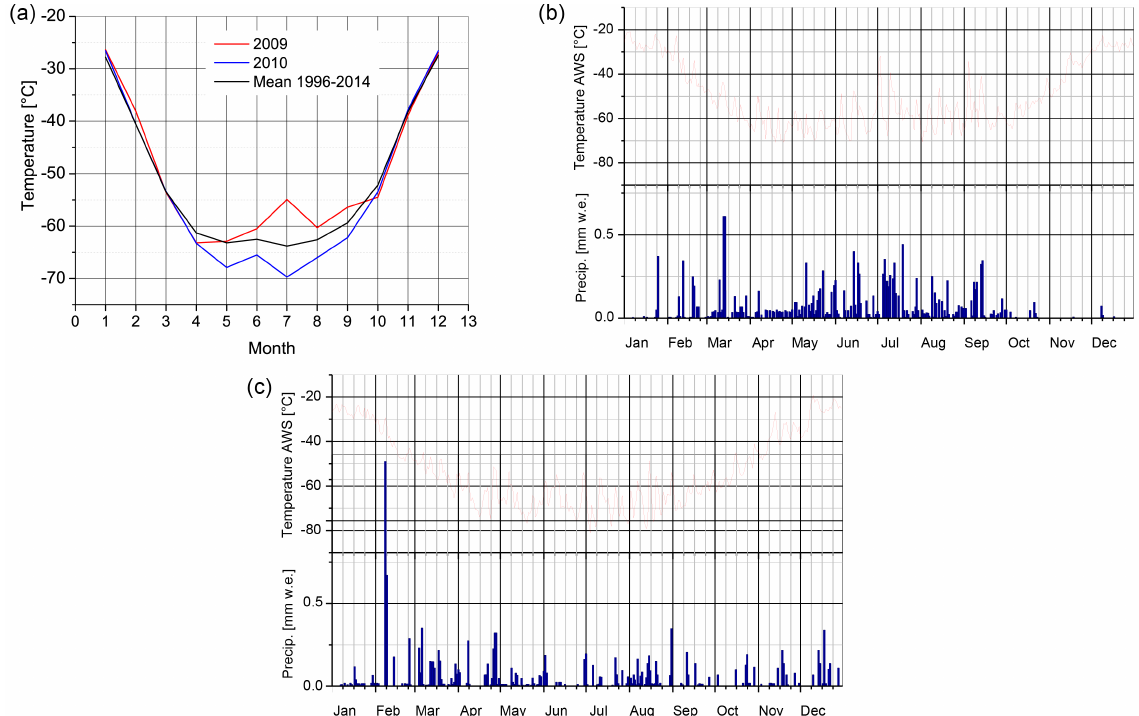
Figure 3. (a) Mean monthly temperatures for 2009 and 2010 at Dome C AWS. (b) Daily precipitation and daily mean temperature at Dome C for 2009 and